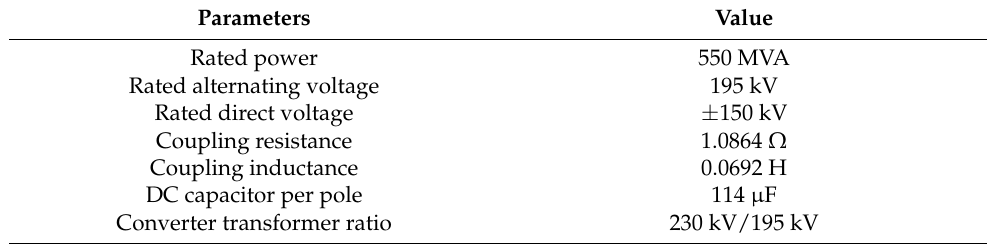
Table A1. Parameters of the VSC-based